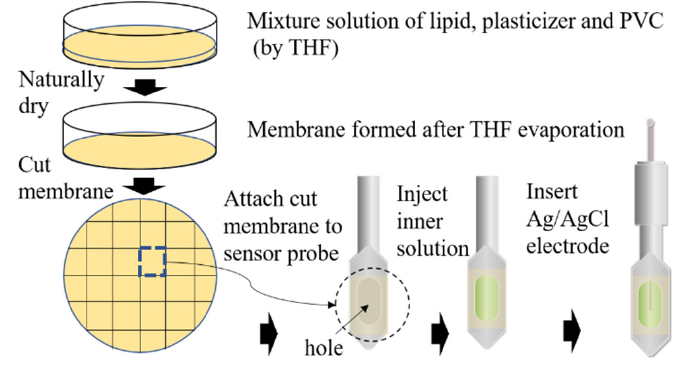
Figure 2. Fabrication process of sensor electrode.